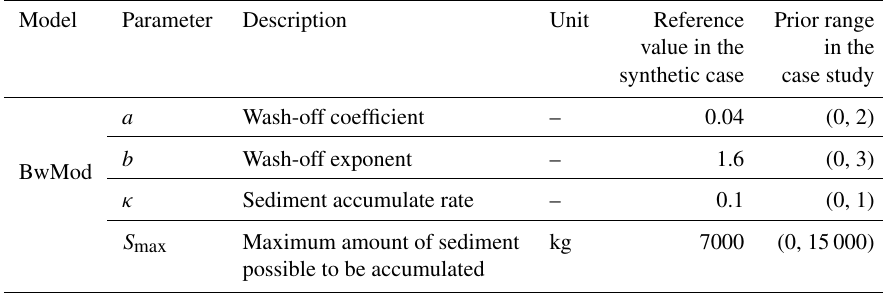
Table 1. Descriptions of BwMod